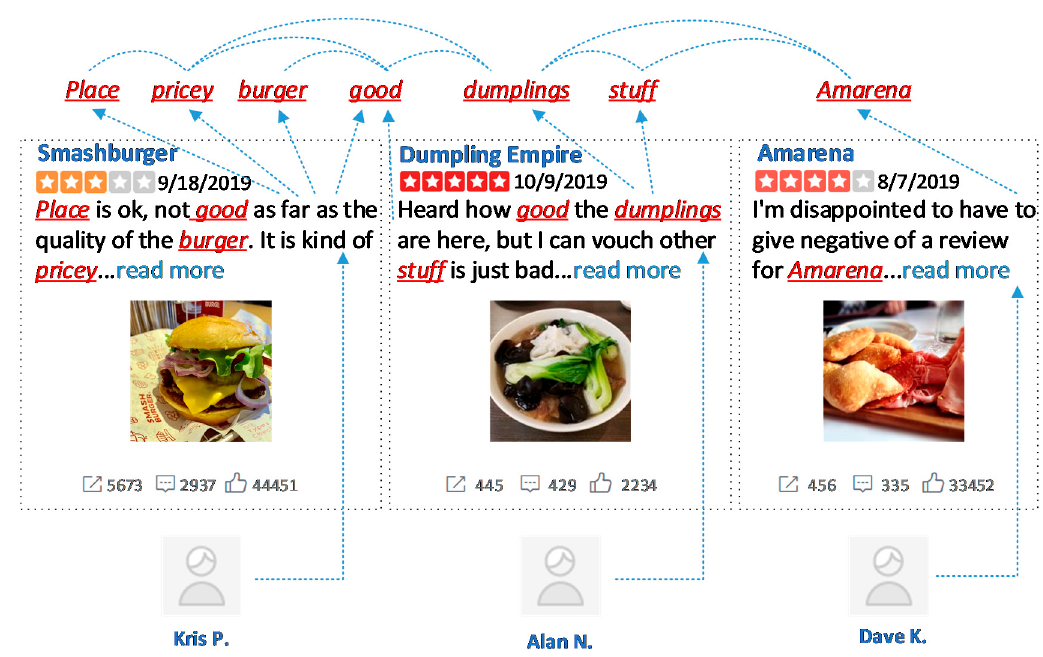
Figure 1. Interactions among words, posts, dates, and users.